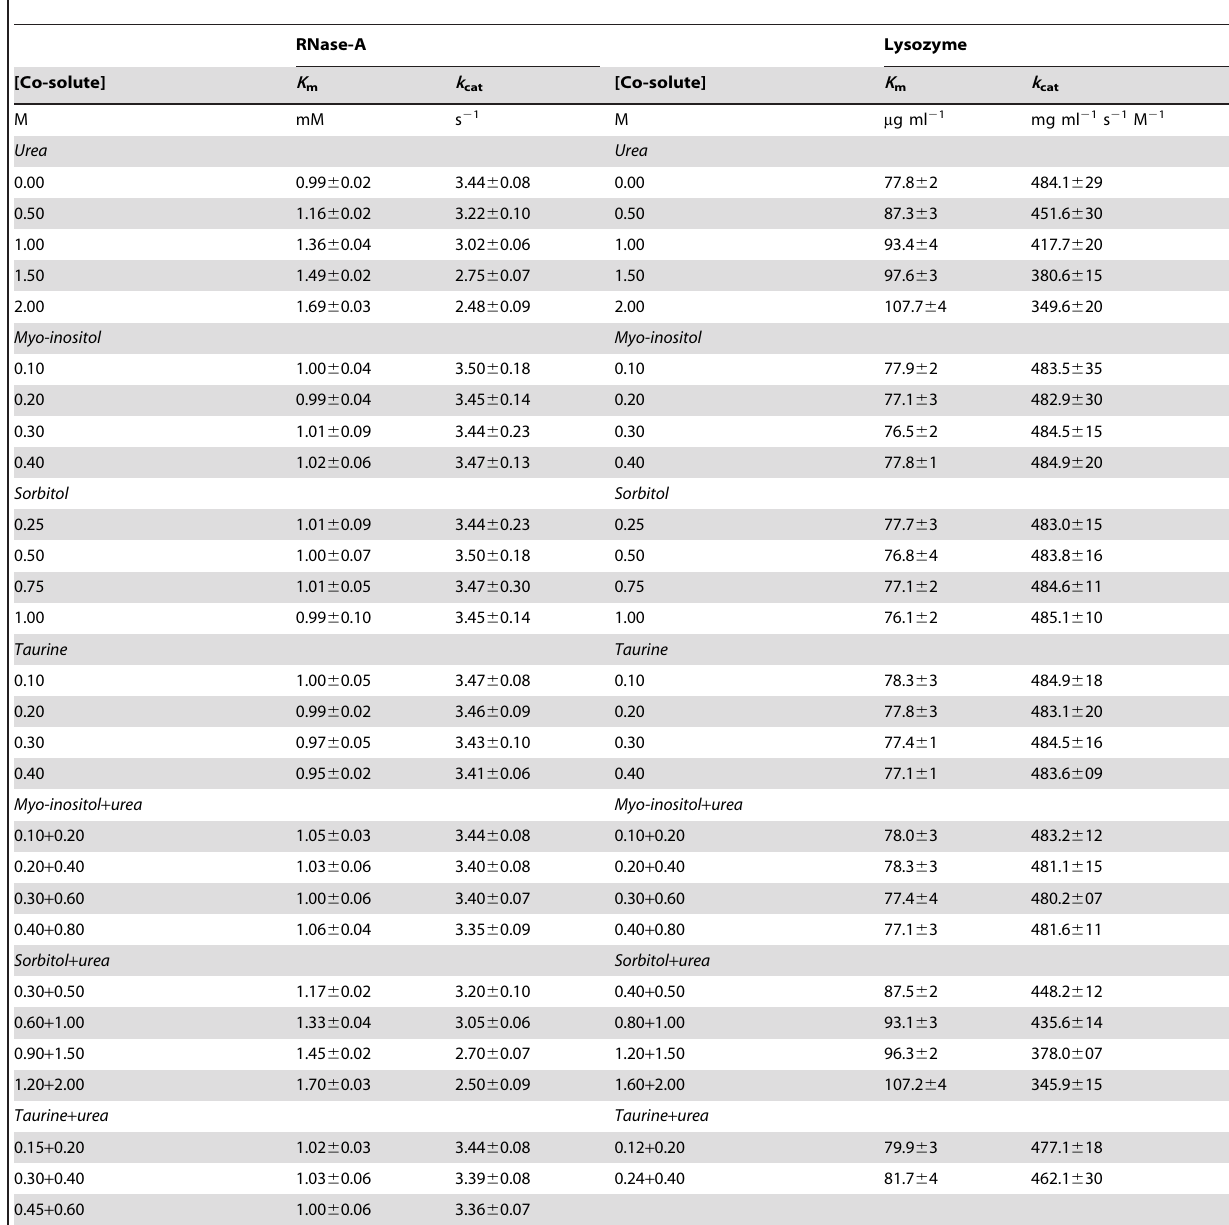
Table 3. Activity parameters of RNase-A and lysozyme in the presence and absence of co-solutes at pH 7.0 and 25 u C. a